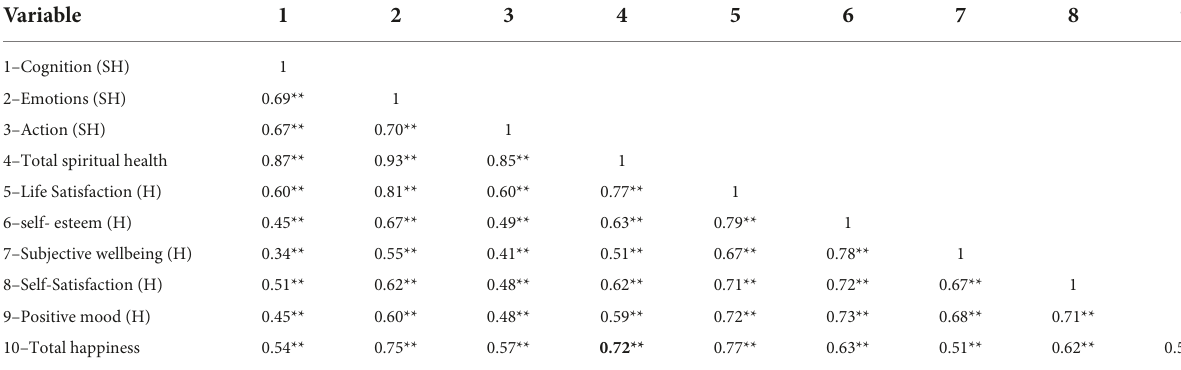
TABLE 3 Correlation coefficient of spiritual health and happiness dimensions in students ( n = 409). Variable